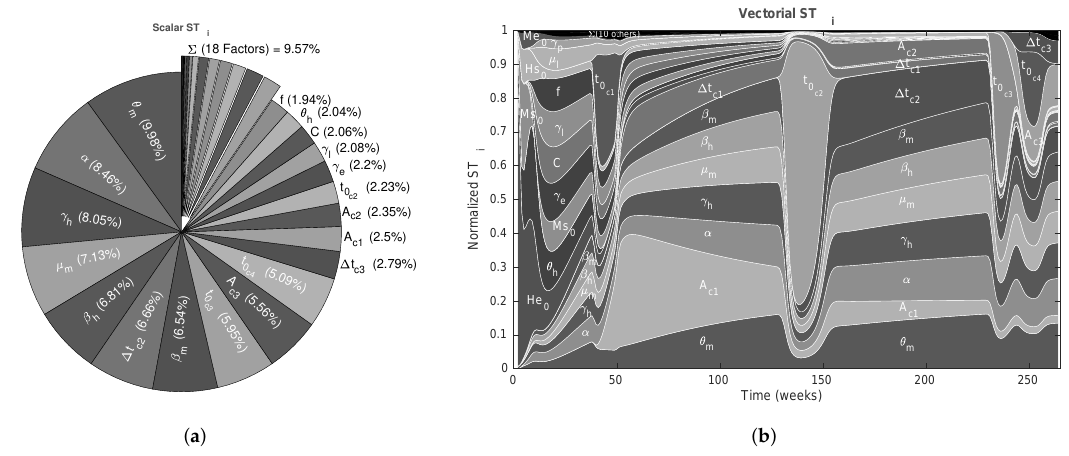
Figure 3. Sensitivity analysis for the CSB intervals. ( a ) The scalar (MSE) SA results for case C and graphical CSB validation using the Xiao method and CSB intervals; ( b ) results of the vectorial SA plotted by time for case C and graphical CSB validation using Xiao’s method with N = 6000 [49].